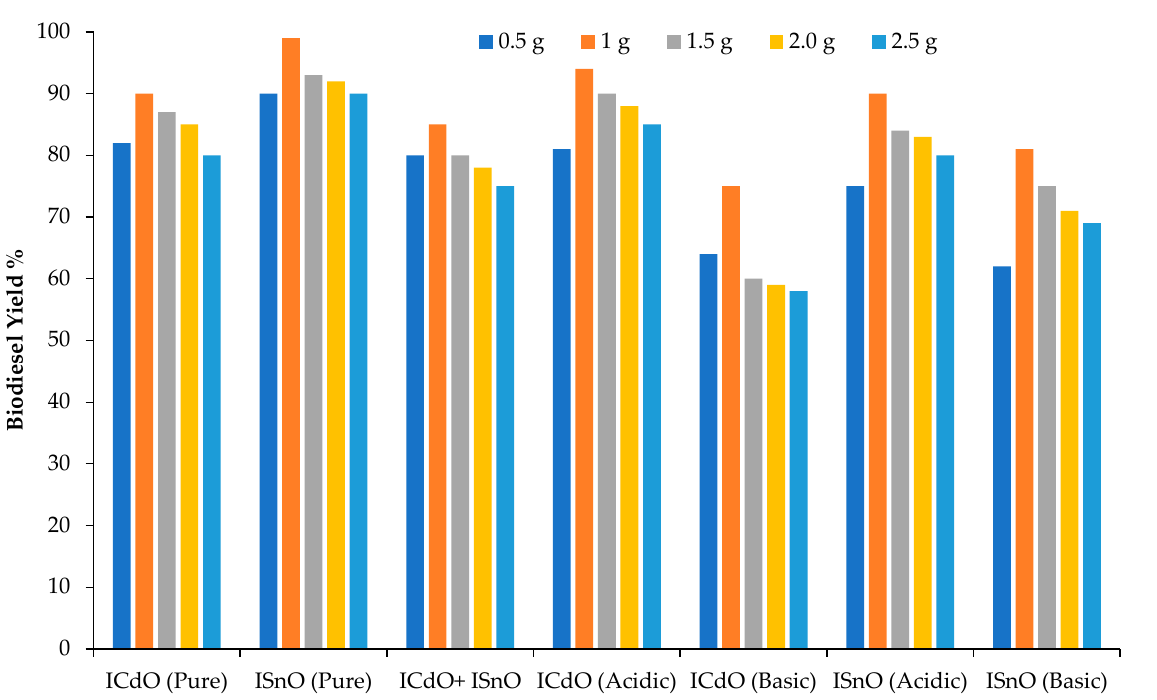
Figure 1. Effect of catalyst concentration on biodiesel yield (oil to methanol molar ratio, 1:10; temper- ature, 60 °C; time, 120 min).